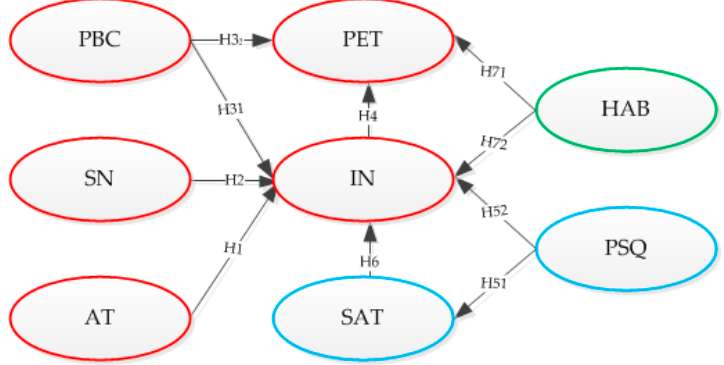
Figure 1. Graphical conceptual model of the hypotheses. PBC, perceived behaviour control; SN, subjective norms; AT, attitudes; PET, pro-environment travel; IN, intentions; SAT, satisfaction; HAB, habit; PSQ, perceived service quality.